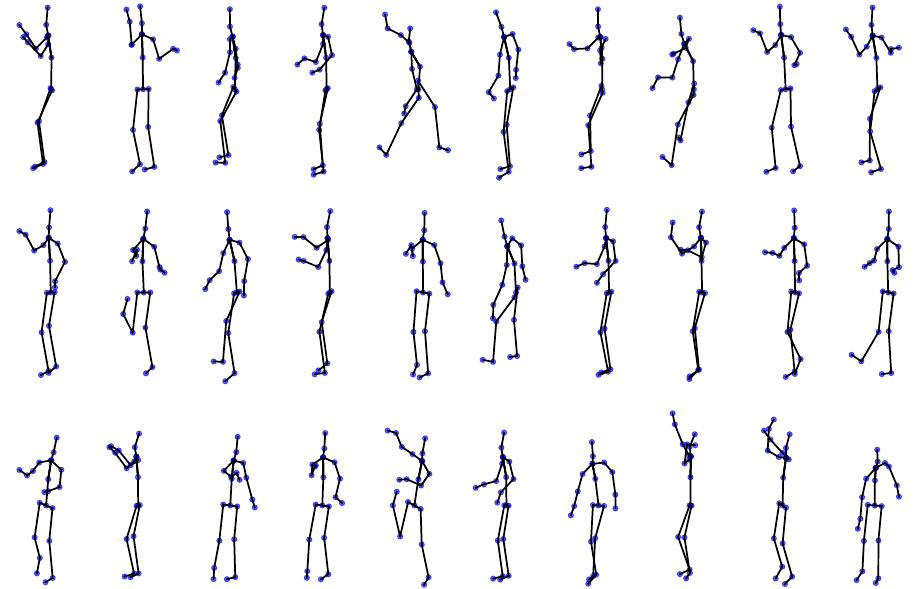
Figure 5. Illustrative results for codebook generation (Tennis-Mocap dataset). Top: forehand ; Middle: volley ; Bottom: Smash